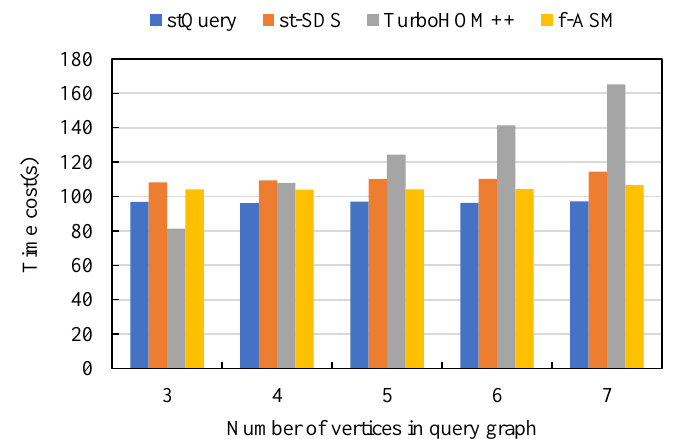
Figure 10. Experimental comparison of the chain query pattern.